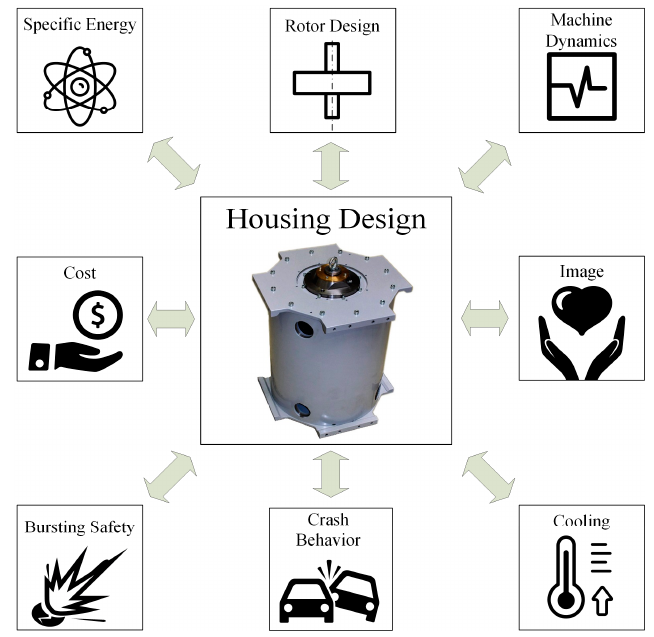
Figure 4 . Eight most relevant aspects of FESS housing / containment design. Figure 4. Eight most relevant aspects of FESS housing / containment